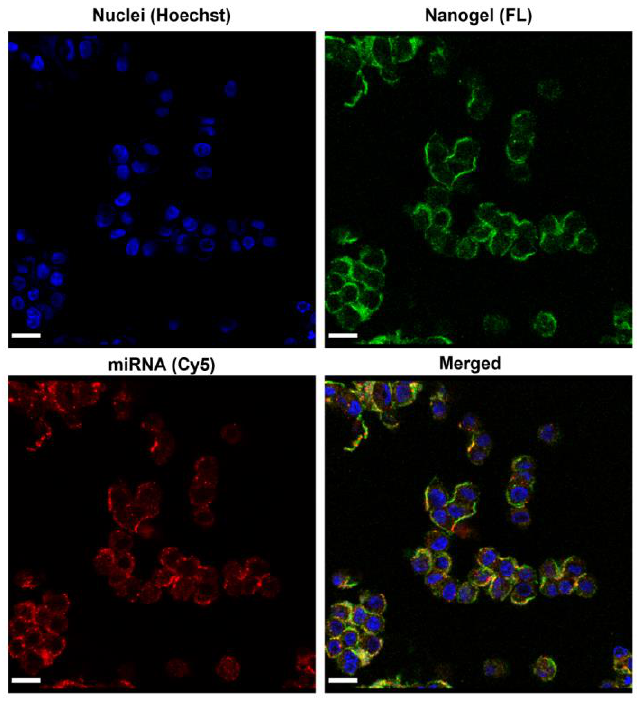
Figure 6. Cell uptake of FL-NG/Cy5-a-miR21-3 in HCT 116 colon cancer cell line (concentration: 500 µ g/mL). Blue color indicates cell nuclei, green color indicates NG, and red color indicates miRNA. Scale bars = 20 µ